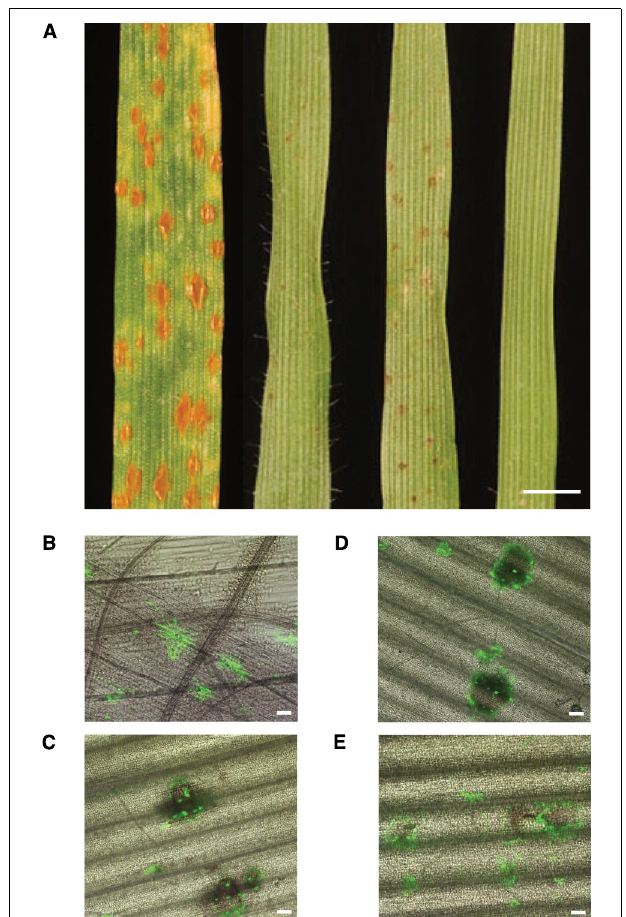
FIGURE 1 | Symptoms induced by P. graminis f. sp. tritici in wheat and B. distachyon . (A) Left to right, macroscopic symptoms of P. graminis f. sp. tritici (CRL 75-36-700-3) in susceptible Triticum aestivum cv. McNair 701, B. distachyon inbred lines Bd1-1, Bd2-3, Bd21 at 12 days after inoculation, scale = 2 mm. (B–E) Microscopic symptoms induced by P. graminis f. sp. tritici and various inbred lines of B. distachyon at 96 h post-inoculation. Inoculations were performed as previously reported (Figueroa et al., 2013). Fungal tissue was stained with wheat germ agglutinin conjugated to fluorescein isothiocyanate (WGA-FITC; Sigma-Aldrich, St. Louis, MO, USA) as previously described (Ayliffe et al., 2013). (B) Susceptible Triticum aestivum cv. McNair 701. (C) Inbred line Bd1-1. (D) Inbred line Bd2-3. (E) Inbred line Bd21. Images were generated by merging bright and fluorescence fields captured using an Olympus IX70 Inverted Fluorescence Microscope, scale = 100 m